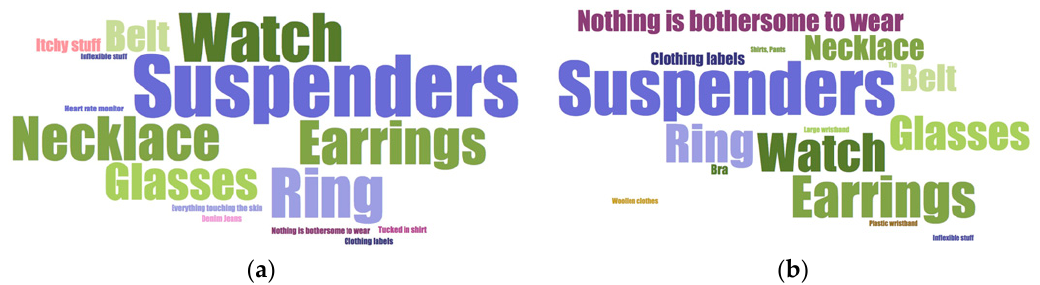
Figure 2. Objects that are bothersome to wear for ( a ) autistic children as noticed by their parents (group 1), and ( b ) for autistic adults (group